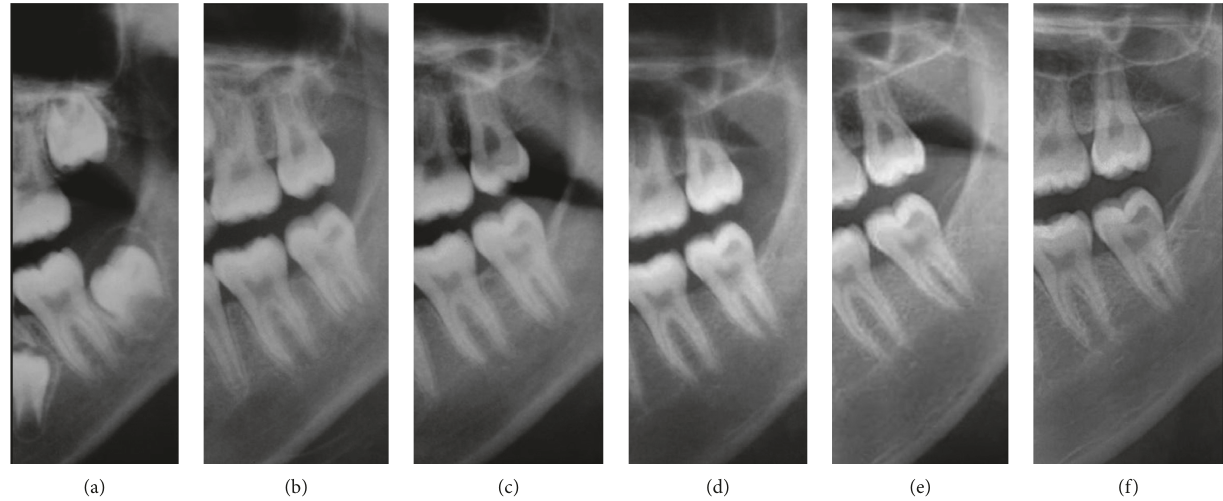
Figure 1: Cropped panoramic radiographs demonstrating a PEIR-affected tooth (permanent mandibular left second molar) when the patient was (a) 8 years, 8 months old, (b) 10 years, 11 months old, (c) 12 years, 5 months old, (d) 13 years, 4 months old, (e) 15 years, 3 months old, and (f) 17 years, 4 months old. There was no obvious progression of PEIR size or changes in the PEIR location noted from this film